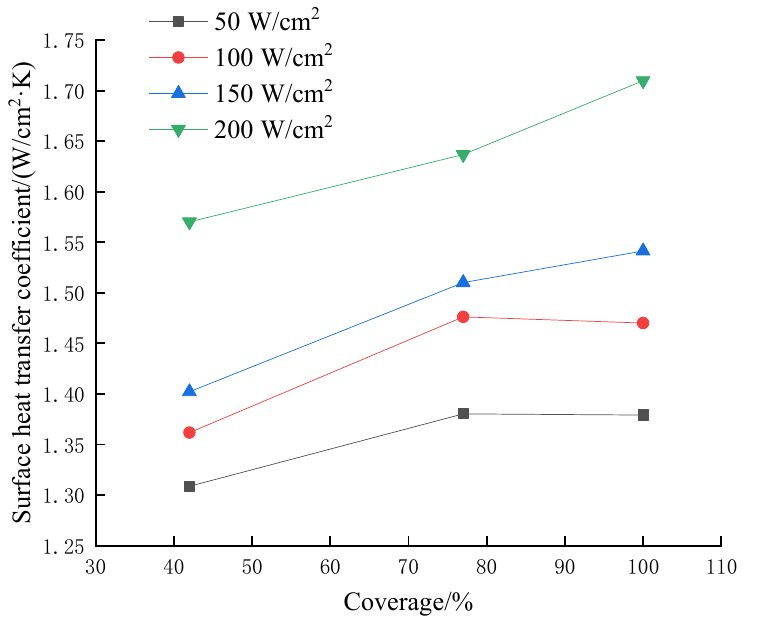
Figure 12. The influence of the coverage rate of the flow rate change on the steady-state surface heat transfer coefficient.